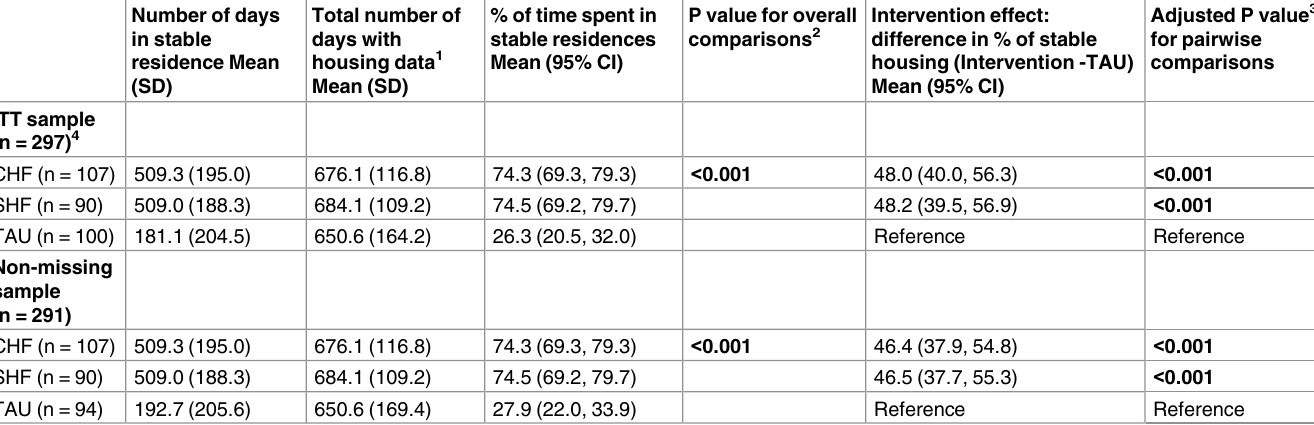
Table 2. Effect of Housing First Intervention on Primary Outcome (percentage of days in stable housing) among VAH participants (n =